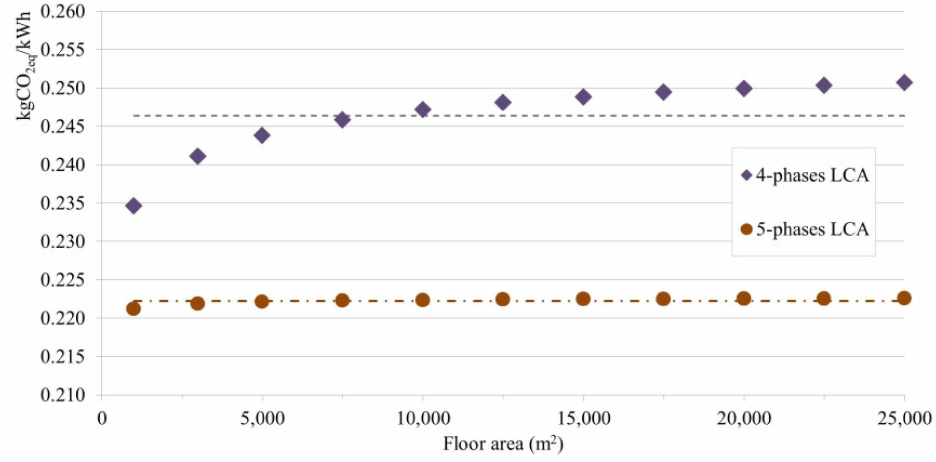
Figure 8. CF per unit primary energy. The four-phases LCA does not include the use